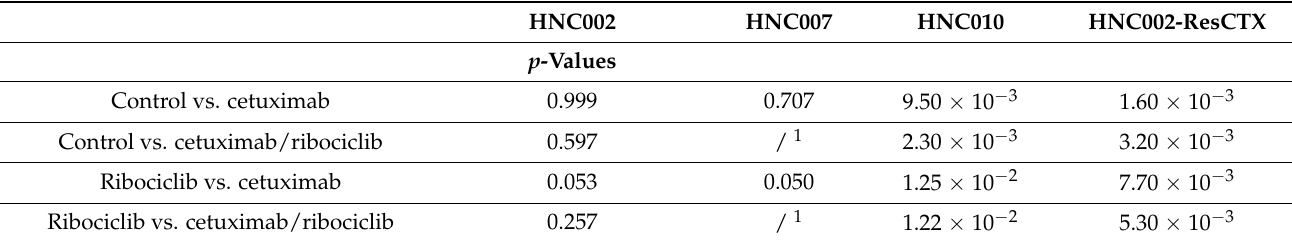
Figure 2. Rb protein expression levels in four HPV-negative SCCHN PDTX models (HNC002, HNC007, HNC010, HNC002-ResCTX); ( a ) Rb protein expression evaluated by immunohistochemistry (we show one representative mouse per model), and ( b ) Rb protein expression measured by histoscore in three mice/treatment/model, except for HNC002 where 2 mice/treatment were measured. In the UCLHN01 and HNC007 models, due to the important efficacy of cetuximab and/or the combination treatment, some of the tumors were too small to be analyzed for protein expression. ( c ) Tumor volumes after 42 days of treatment are represented for each treatment group, except for the tumor volume of HNC007 treated with ribociclib, which was reported after 28 days of treatment due to important tumor size. n.a.; not available, n.s. (no significance): p > 0.05; * p < 0.05; ** p < 0.001; *** p < 0.0001. Table 1. p -Values of Rb protein expression in PDTX tumors chronically exposed to cetuximab compared to controls or ribociclib monotherapy (associated with Figure 2). In the UCLHN01 and HNC007 models, due to the efficacy of the cetuximab and/or combination treatments, tumors were too small to be analyzed for protein